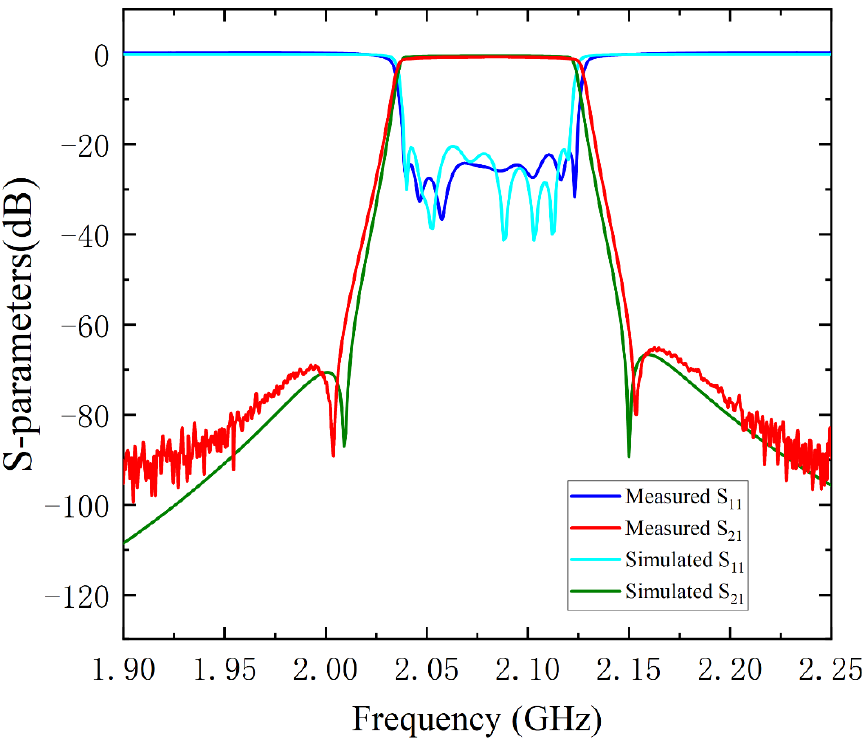
Figure 10. Measured response of a new 2080 MHz capacitively loaded cavity-filter, processed.